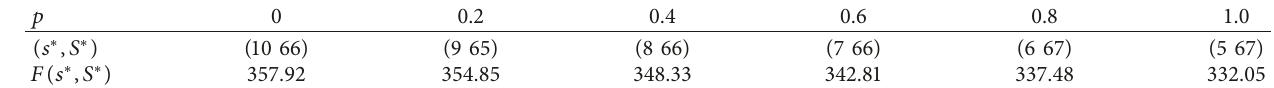
Table 6: The effect of the parameter p on the optimal policy and the optimal